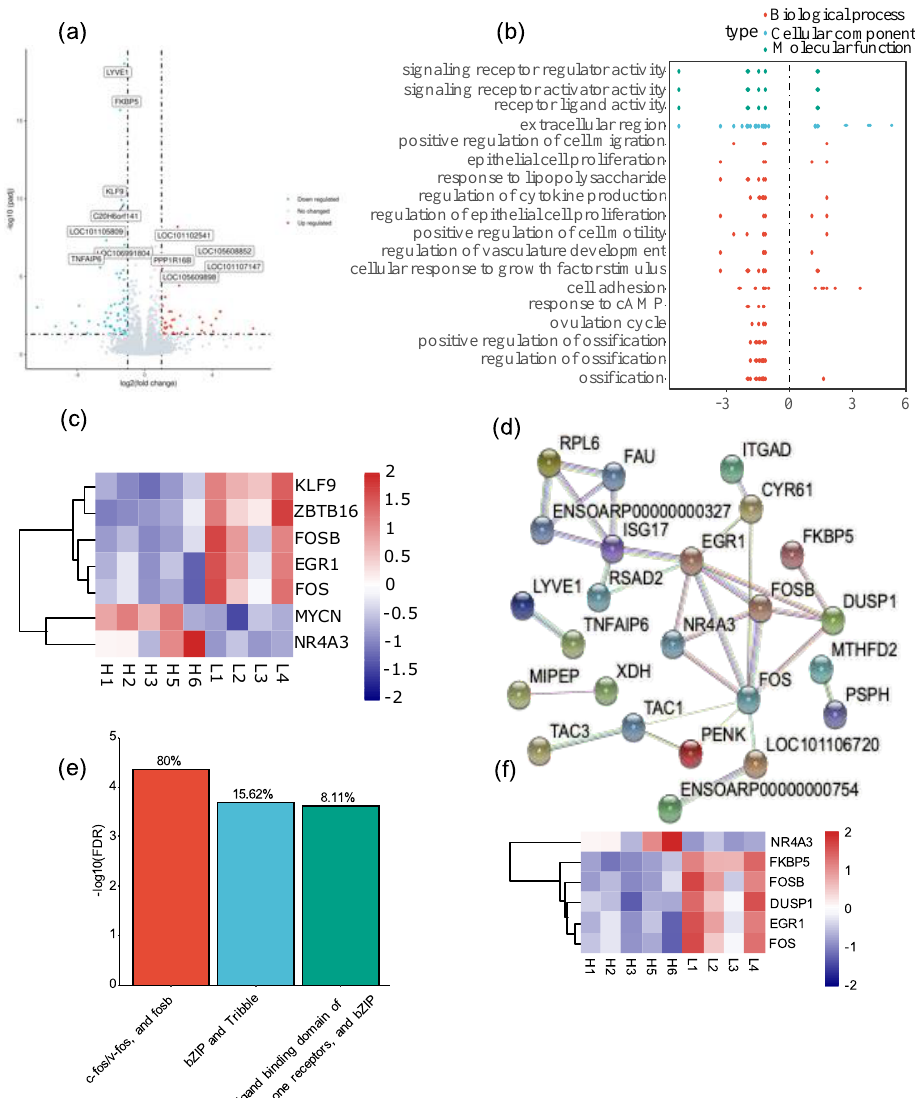
Figure 1. High-altitude stress induced differential expression of follicle development genes. ( a ) The volcano plot highlights the most significant differential expressed genes of ovarian tissues under high-altitude stress in Tibetan sheep; the significant difference cut-off criterion is p < 0.05 and |log2Fold Change| > 1; blue dots, the significantly downregulated genes; red dots, upregulated genes under high-altitude stress. ( b ) Gene ontology enrichment of differential expressed genes; the dots of different color represent the classification group of the function. ( c ) The heatmap of high- altitude stress-associated transcription factors. ( d ) The protein–protein-interaction (PPI) network of DEGs; each of the nodes represents a protein. ( e ) The functional enrichment clusters in the DEGs’ PPI network, the horizontal axis is the description of local network cluster. The left vertical axis is the FDR. The percentage on the column is the ratio of the number of genes clustered to each entry to the total number of genes in the entry. ( f ) The heatmap of high-altitude stress-associated transcription factor from PPI